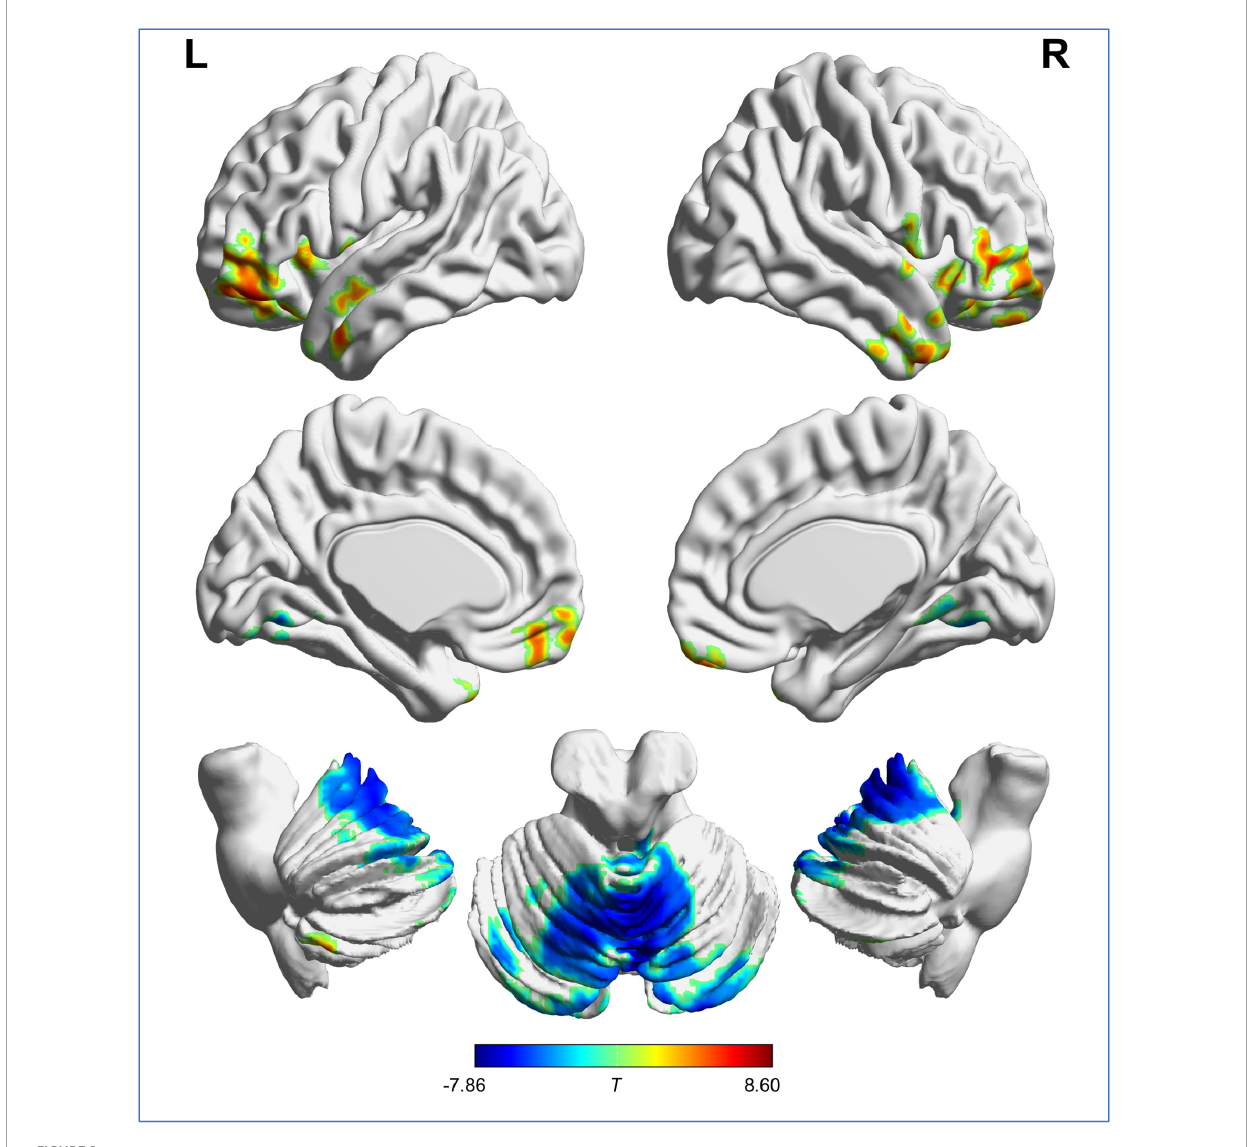
FIGURE2 Brain regions with significant difference in ISO between RW and SD. “L” and “R” represent the left and right side of the brain, respectively. Red indicates ISO reduction and blue indicates ISO increment after SD. ISO, isotropic volume fraction; RW, rested wakefulness; SD, sleep deprivation.